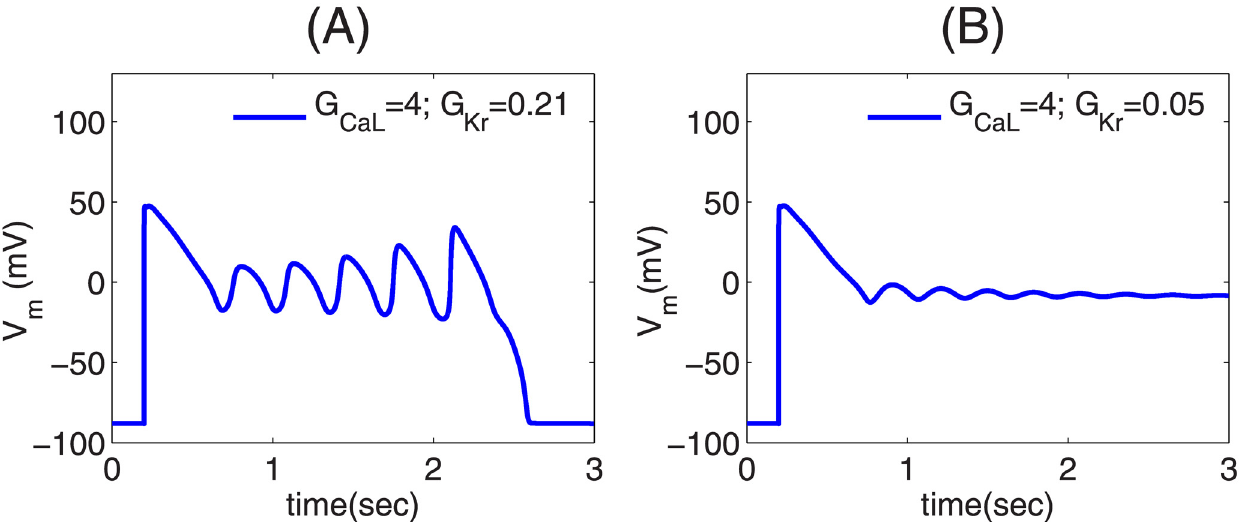
Fig 2. Plots of V m versus time illustrating the two types of APs. (A) Type-I AP with the EAD oscillations increasing with time until the cell repolarizes to the resting membrane potential; (B) Type-II AP, with decaying EAD oscillations, which relax to a higher potential than the normal resting membrane potential. The parameter sets of the APs are given in the top-right corners of the